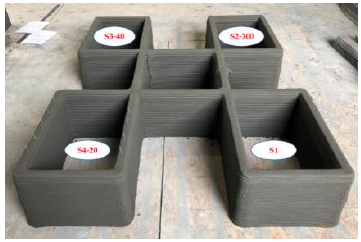
Figure 6. Printed structures.